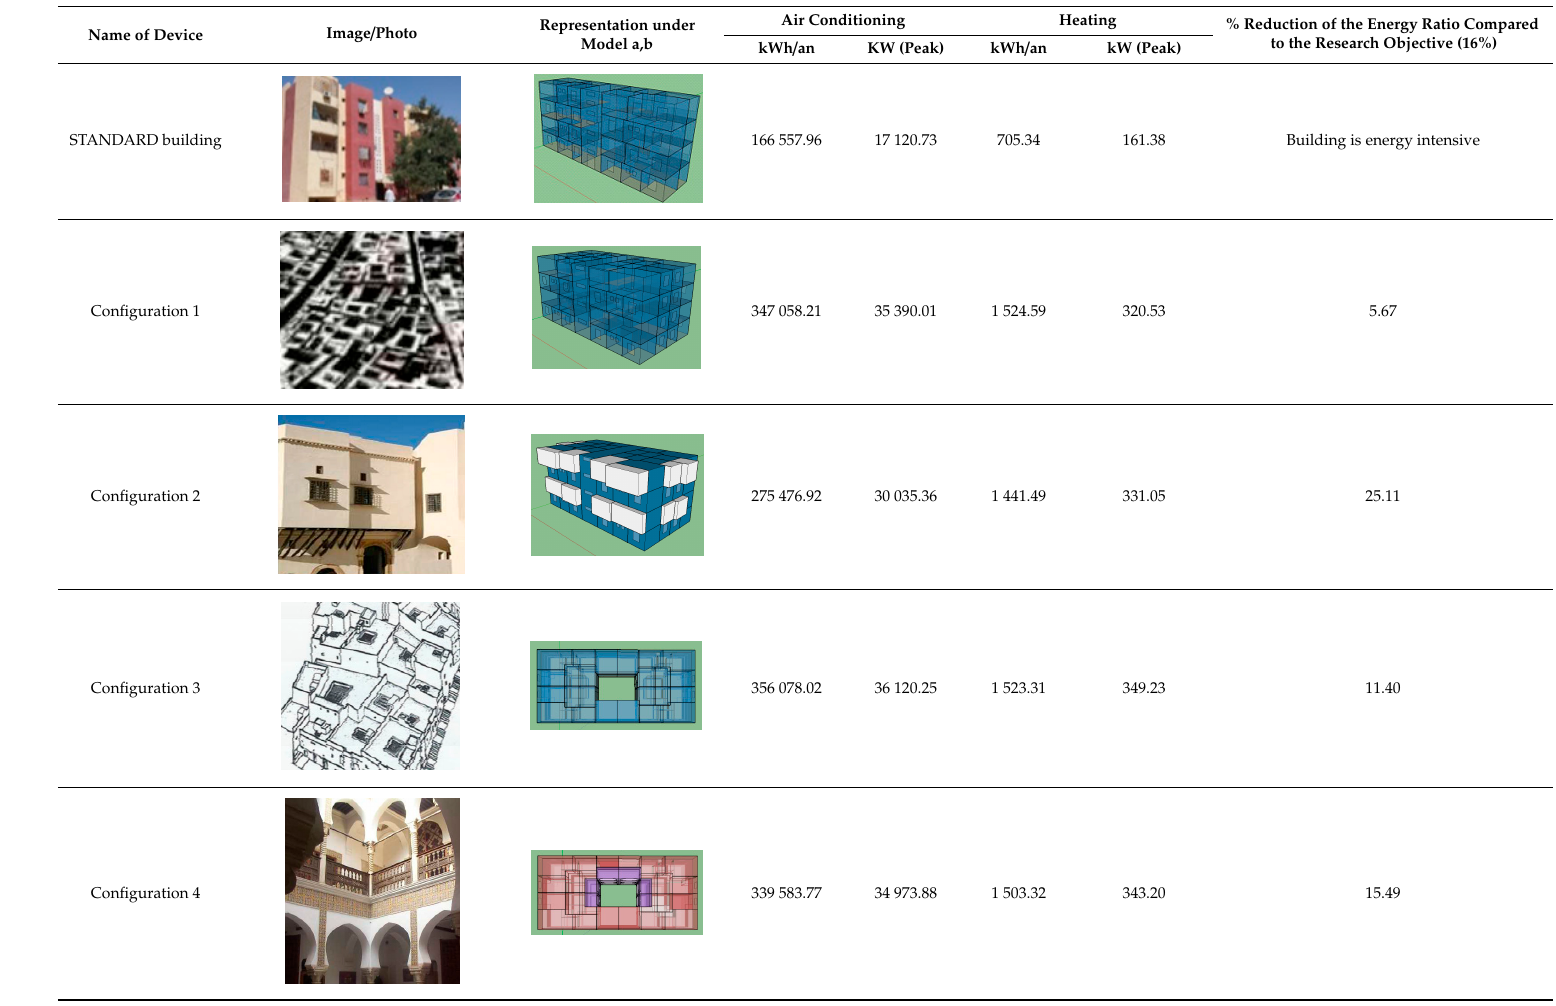
Table 4. Annual Cooling/Heating Loads Results and Reduction Rate Compared to the Reference Building, and Research Objective for Buildings Corresponding to Different Configurations.